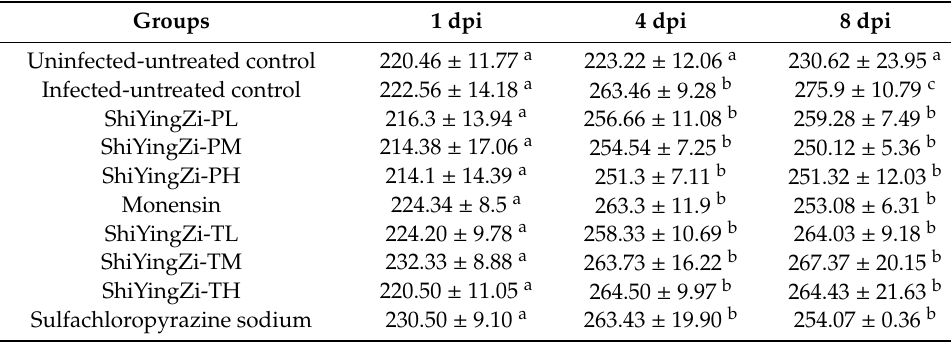
Table 11. The aspartate aminotransferase content (U /